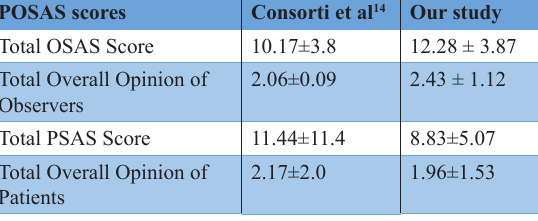
Table 7 Comparison of POSAS score of group II in our study with subcutaneous continuous group of Consorti et al 14